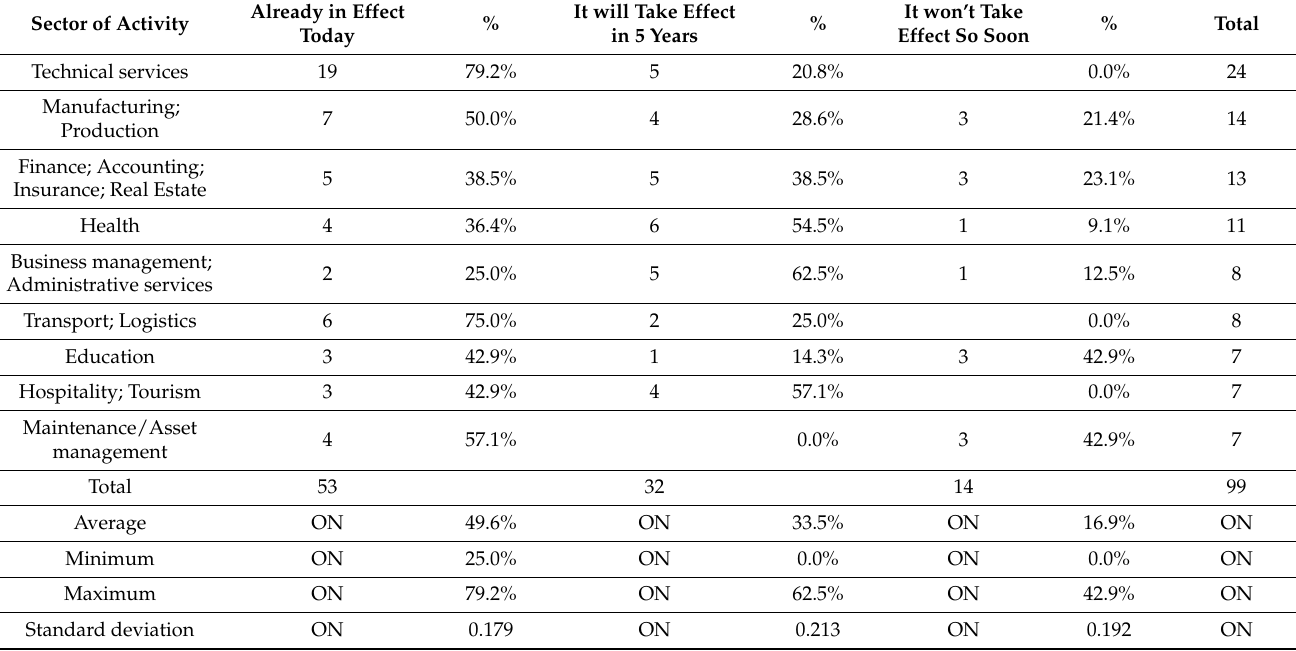
Table 4. Results by activity sector to the question: How soon do you think the adoption of intelligent systems will have an effect on your company’s